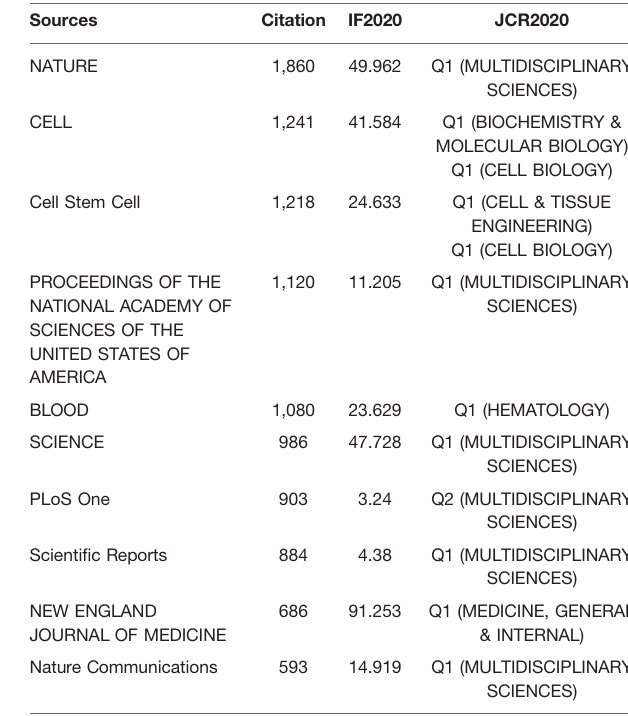
TABLE 4 | The 10 most co-cited journals of stem cell precision medicine research from 2018 to